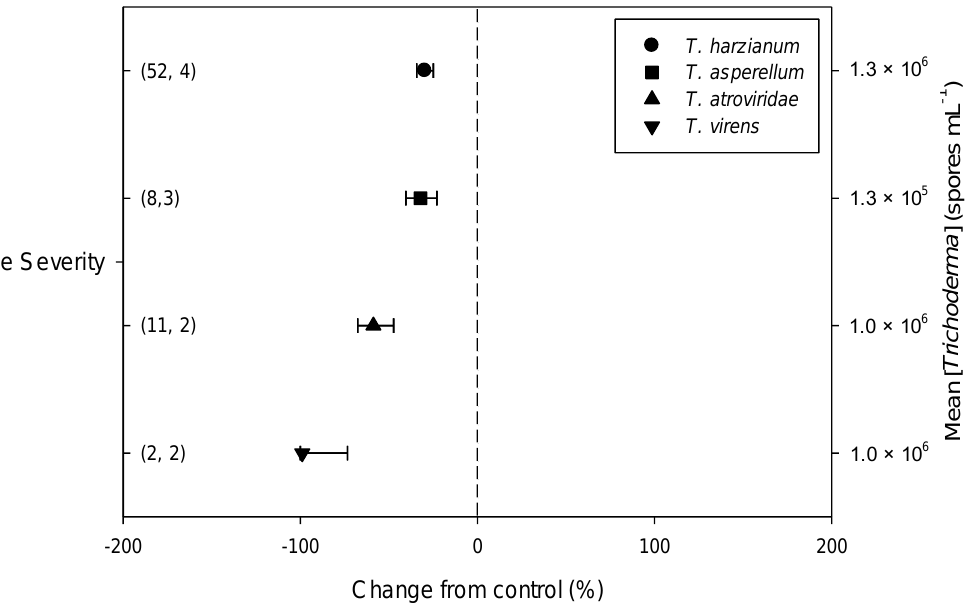
Figure 3. Differential effects of Trichoderma on Botrytis cinerea infection (i.e., disease severity) in tomato leaves on the basis of Trichoderma species ( Trichoderma harzianum , T. asperellum , T. atroviridae and T. virens ). Symbols represent the mean percentage change due to Trichoderma treatment relative to control (i.e., B. cinerea infection without Trichoderma treatment), and the bars show the 95% confidence interval. Number of observations and papers are shown in parentheses; mean Trichoderma spp. concentrations are given along the right y axis.